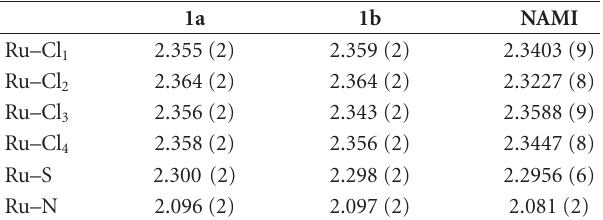
Table 3: Selected hydrogen bond short contact distances in compound 1b .